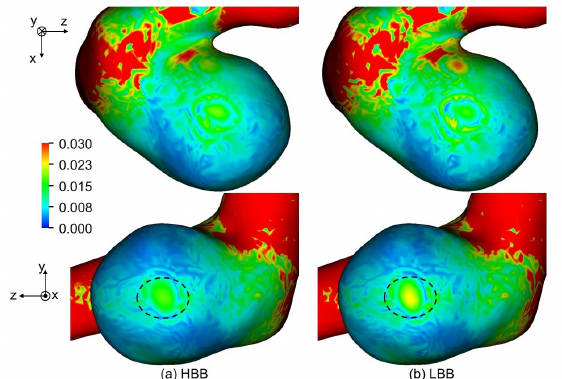
Figure 14. Comparison of TAWSS between ( a ) HBB and ( b ) LBB (the spatial resolution: N x = 162; TAWSS is normalized with ρ U 2 /2).